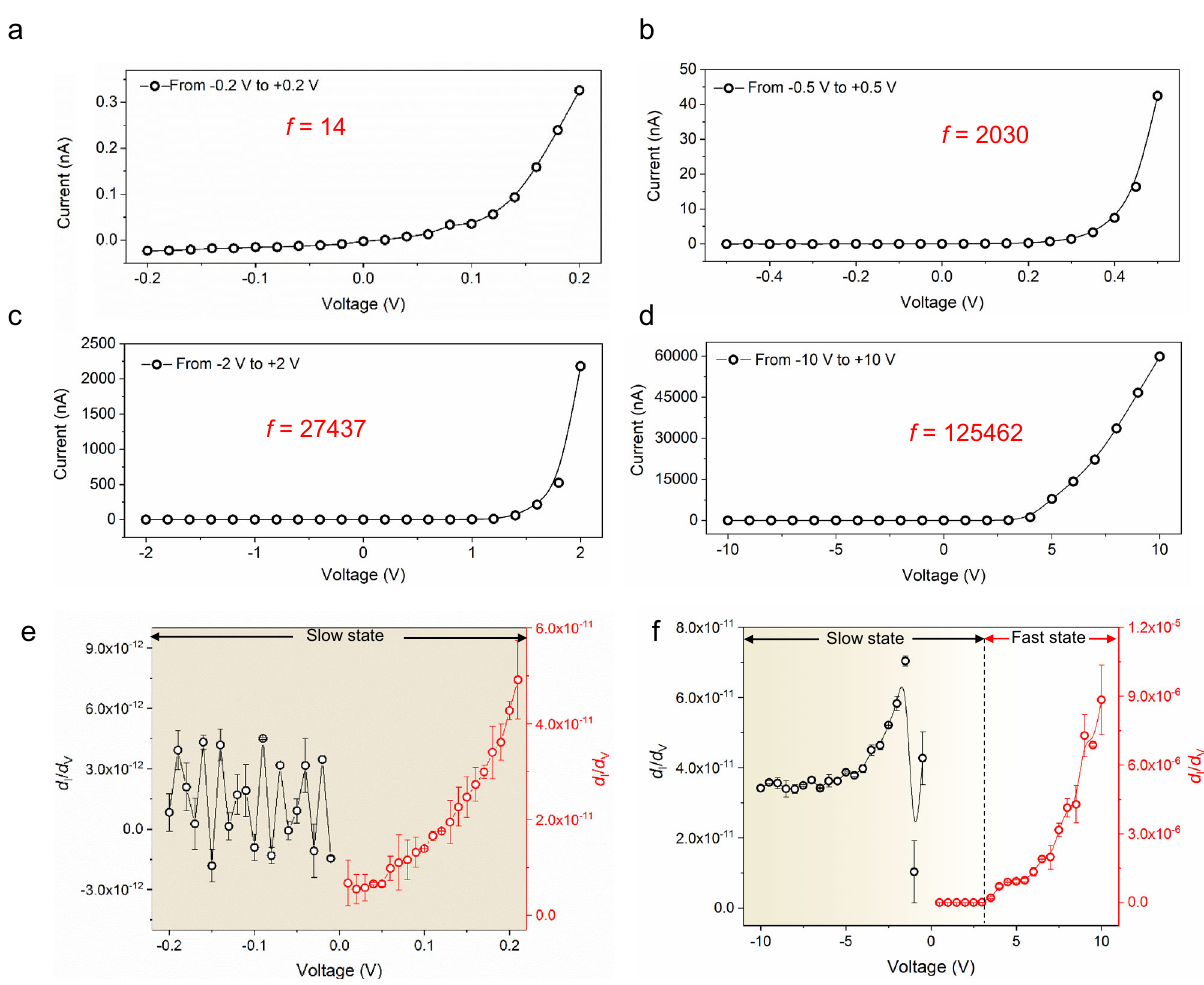
Fig. 4 Voltage-dependent ionic recti fi cation properties. Ion transport properties and calculated recti fi cation ratio at different scanning voltages ( a – d ), and calculated current growth curves d I / d V at low voltage (from − 0.2 to + 0.2 V) ( e ) and high voltage (from − 10 to 10 V) ( f ). The measured error bar in a – d is below 1% and therefore not plotted. Error bars represent standard deviations from fi ve independent